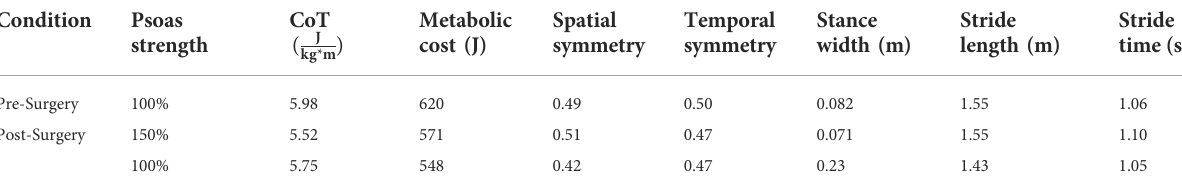
TABLE 4 Comparison of experimental pre-surgery and predicted post-surgery clinical gait measures. Psoas strength is indicated as percent of pre- surgery value